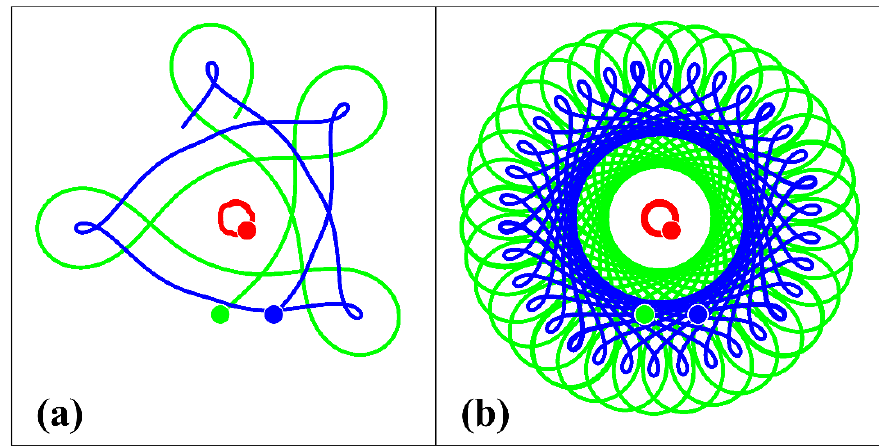
Figure 6. The trajectories of the two-layer point vortex structure when an two middle layer vortices run into a surface cyclone in the time intervals equal to about 4 loop-like rotations ( a ) and about 40 loop-like rotations ( b ) at 𝐿 = 5, 𝐵 = −16, 𝛬 21 𝛬 11 ⁄ = 1 8⁄ , and 𝛬 21 𝛬 22 ⁄ = −1 2⁄ . All vortices begin their motion from the initial positions in the cyclonic direction.